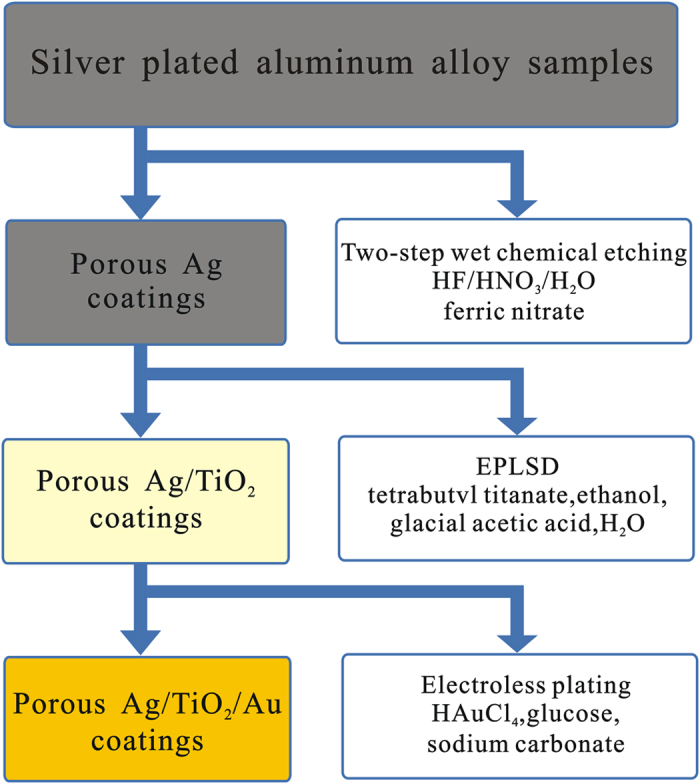
Scheme of the overall synthetic process developed to prepare Ag/TiO2/Au coatings.